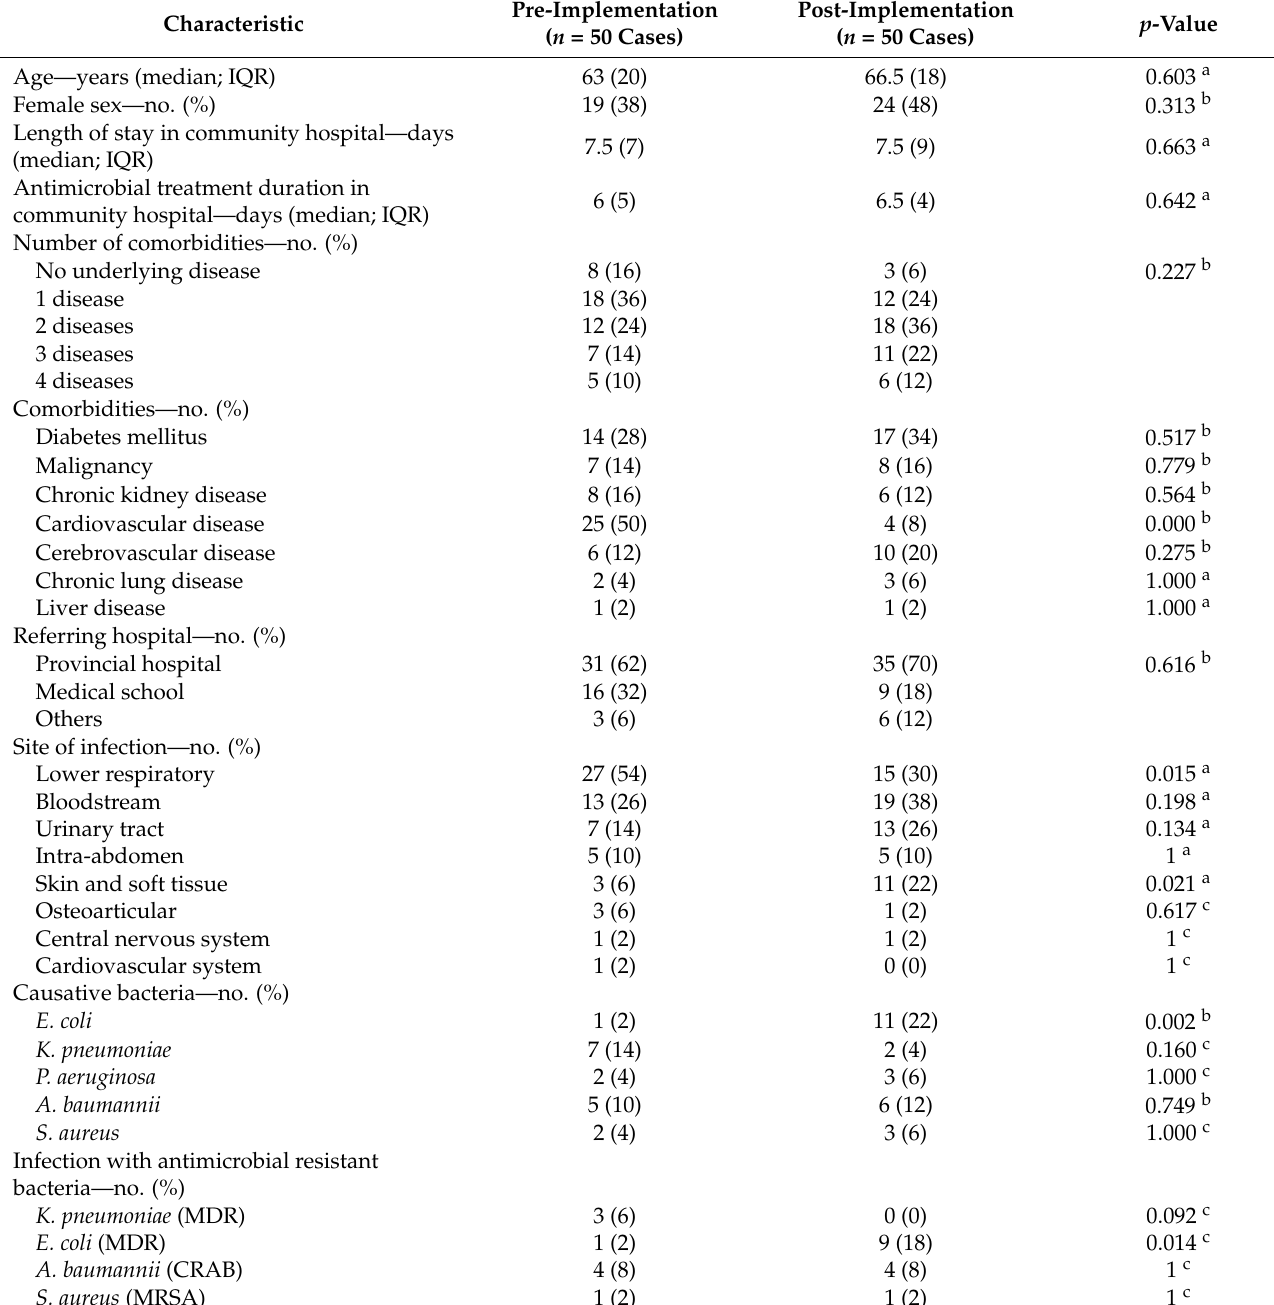
Table 1. Baseline characteristics of the patients and classification of antimicrobial therapy in the pre-implementation and post-implementation